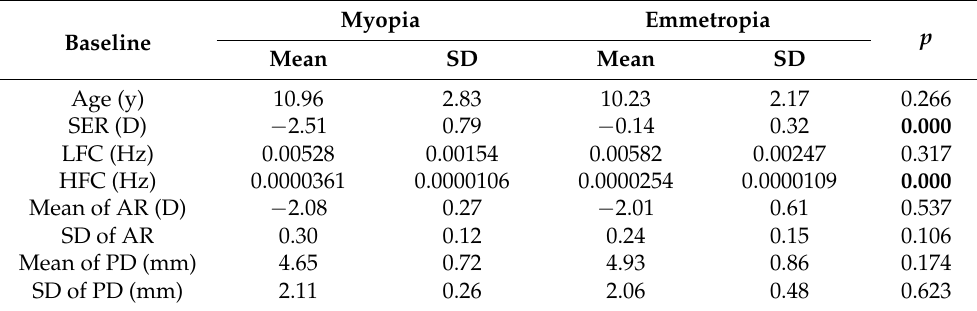
Table 1. Descriptive statistics measured over the baseline duration of two refractive groups. Myopia Baseline